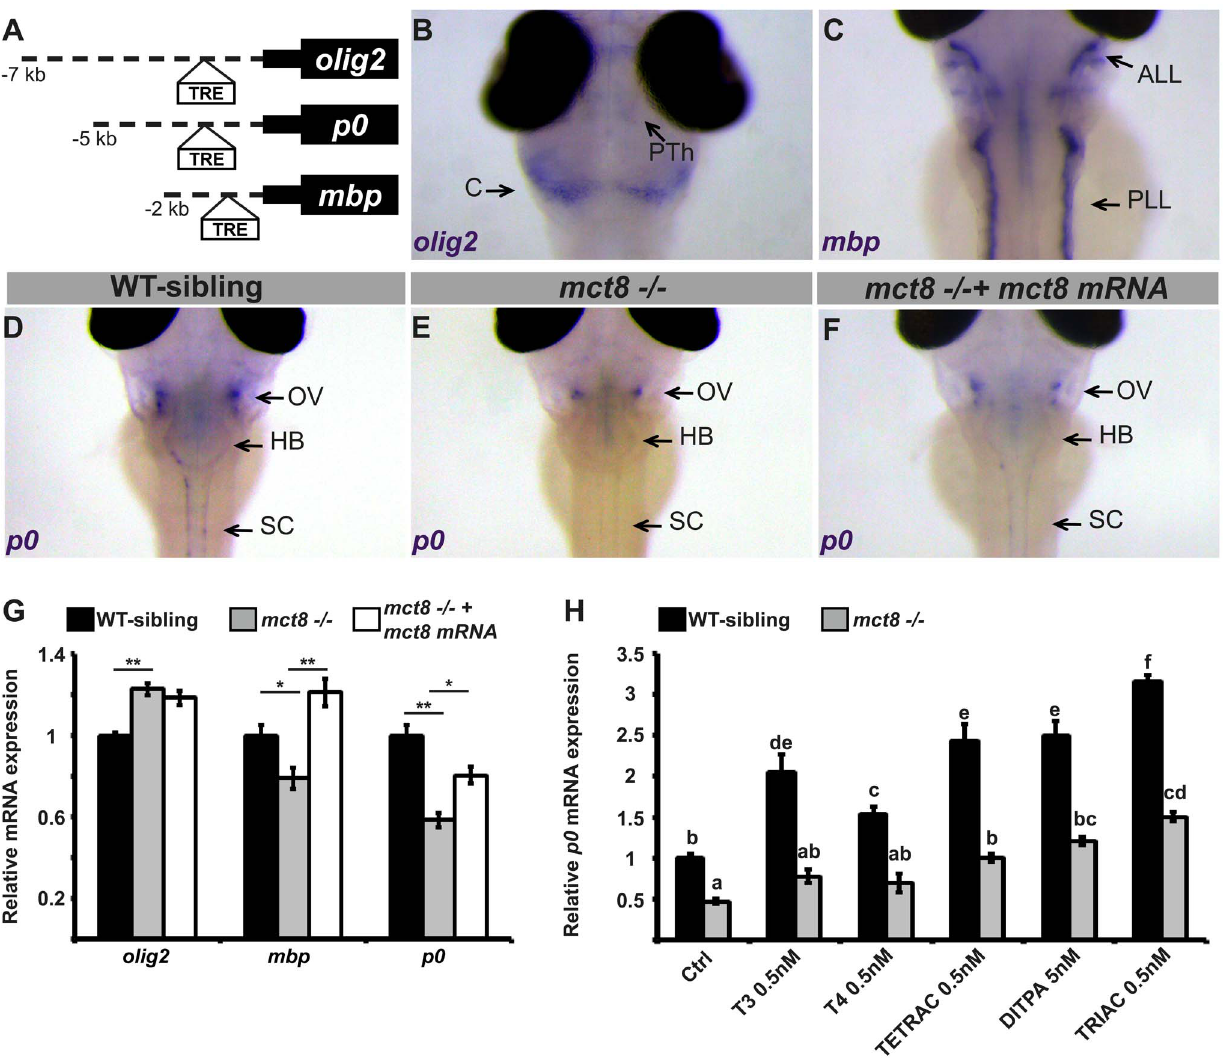
Figure 3. Altered expression of myelin-related genes in mct8 2 / 2 embryos is recovered by TH analogs. A . The location of putative thyroid response elements (TRE) in the 7, 5, and 2 kb promoter regions of the zebrafish olig2 , p0 , and mbp genes, respectively. B–F . Whole-mount ISH experiments detected the spatial mRNA expression in 3 dpf embryos (dorsal views) B . olig2 is predominantly expressed in the prethalamus (PTh) and cerebellum (C). C . mbp is expressed primarily in the anterior and posterior lateral line (ALL and PLL, respectively). D . p0 is primarily expressed in a cluster of cells above the otic vesicle (OV), the HB, and spinal cord (SC) in WT-sibling embryos. E . Low expression levels were detected above the otic vesicle in mct8 2 / 2 embryos. F . The expression pattern of p0 was recovered in mct8 mRNA-injected mct8 2 / 2 embryos. G . Relative mRNA expression of olig2 , mbp , and p0 in 3 dpf WT-sibling, mct8 2 / 2 , and mct8 mRNA-injected mct8 2 / 2 embryos. Values represented as means 6 SEM (standard error of the mean). Statistical significance determined by one-way ANOVA followed by a Tukey test (* p , 0.05 , ** p , 0.001 ). H . Relative mRNA expression of p0 in 3 dpf WT-sibling and mct8 2 / 2 embryos treated with 0.5 nM T3, 0.5 nM T4, 0.5 nM TETRAC, 5 nM DITPA, and 0.5 nM TRIAC compared to control (Ctrl, treated with 5 6 10 2 6 M NaOH) WT-sibling and mct8 2 / 2 embryos. Values represented as means 6 SEM. Statistical significance determined by two-way ANOVA followed by a Tukey test. Different letters indicate significant difference.